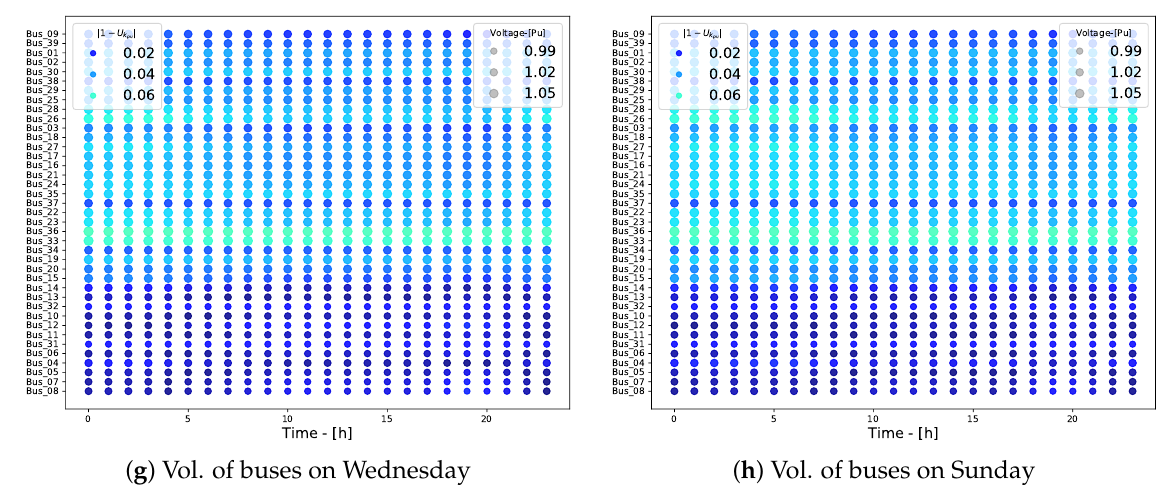
Figure 4. Operating conditions assuming a normal operation of the IEEEE 39 Bus System and considering load forecasting for the first assessed